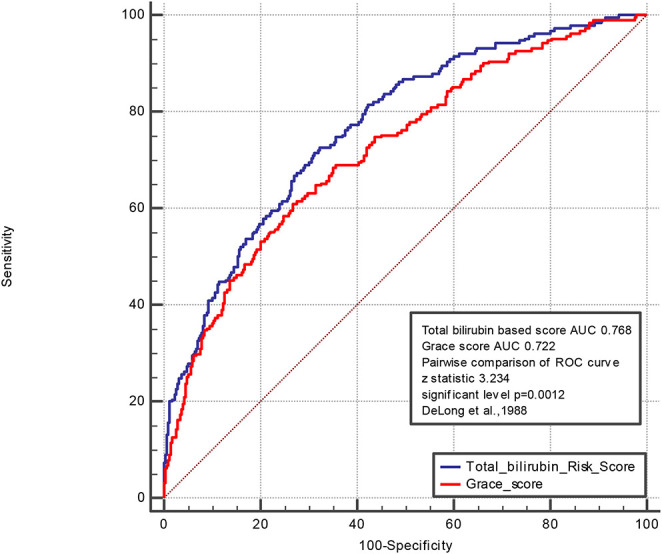
Pairwise comparison of ROC curve of Total bilirubin based score and Grace score. The areas under the curve of the TBil-based score and GRACE score were 0.768 and 0.722, respectively (p = 0.0012). We control the variables including age, history of diabetes mullets, history of atrial fibrillation, hyperlipidemia, history of CABG, history of PCI, current smoking, the serum level of LDL, CRP, Cr, Egfr, D-dimer, LPA, HDL, TG, heart rate, systolic blood pressure, diastolic blood pressure, height, weight, the use of ARB, statin, aldactone, diuretic, left main coronary artery lesion, percutaneous transluminal coronary angioplasty, bifurcation lesion, the peak level of troponin.